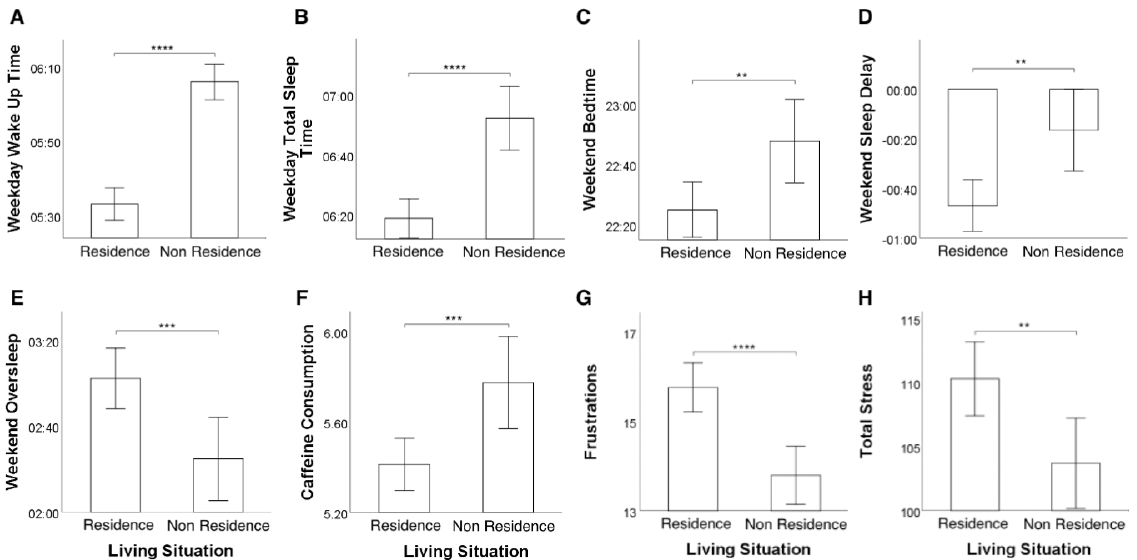
Figure 2. Bar plots representing the significant differences in terms of sleep patterns and academic stress across living situation groups. Specifically, the figure reports differences across living situation groups in terms of: ( A ) weekday wake up time; ( B ) weekday total sleep time; ( C ) weekend bedtime; ( D ) weekend sleep delay; ( E ) weekend oversleep; ( F ) caffeine consumption; ( G ) stress derived from frustrations; and ( H ) total stress (** p < 0.01; *** p < 0.001; **** p <